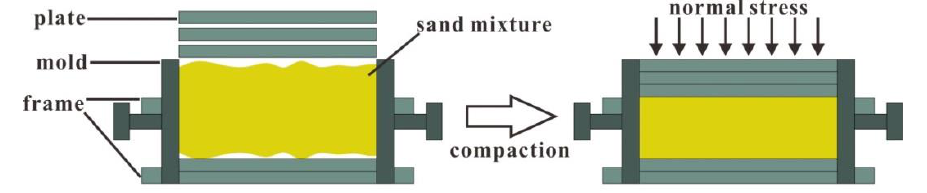
Figure 4. The compaction process of a specimen.